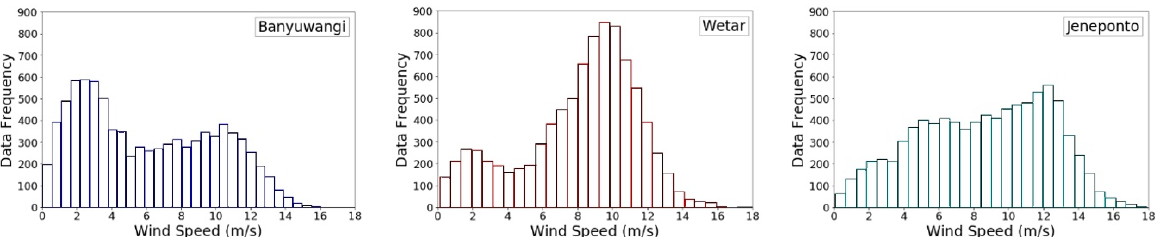
Figure 6. Wind speed distribution for Banyuwangi, Wetar, and Jeneponto. Differences in wind distribution in the rainy and dry seasons were supplementary to